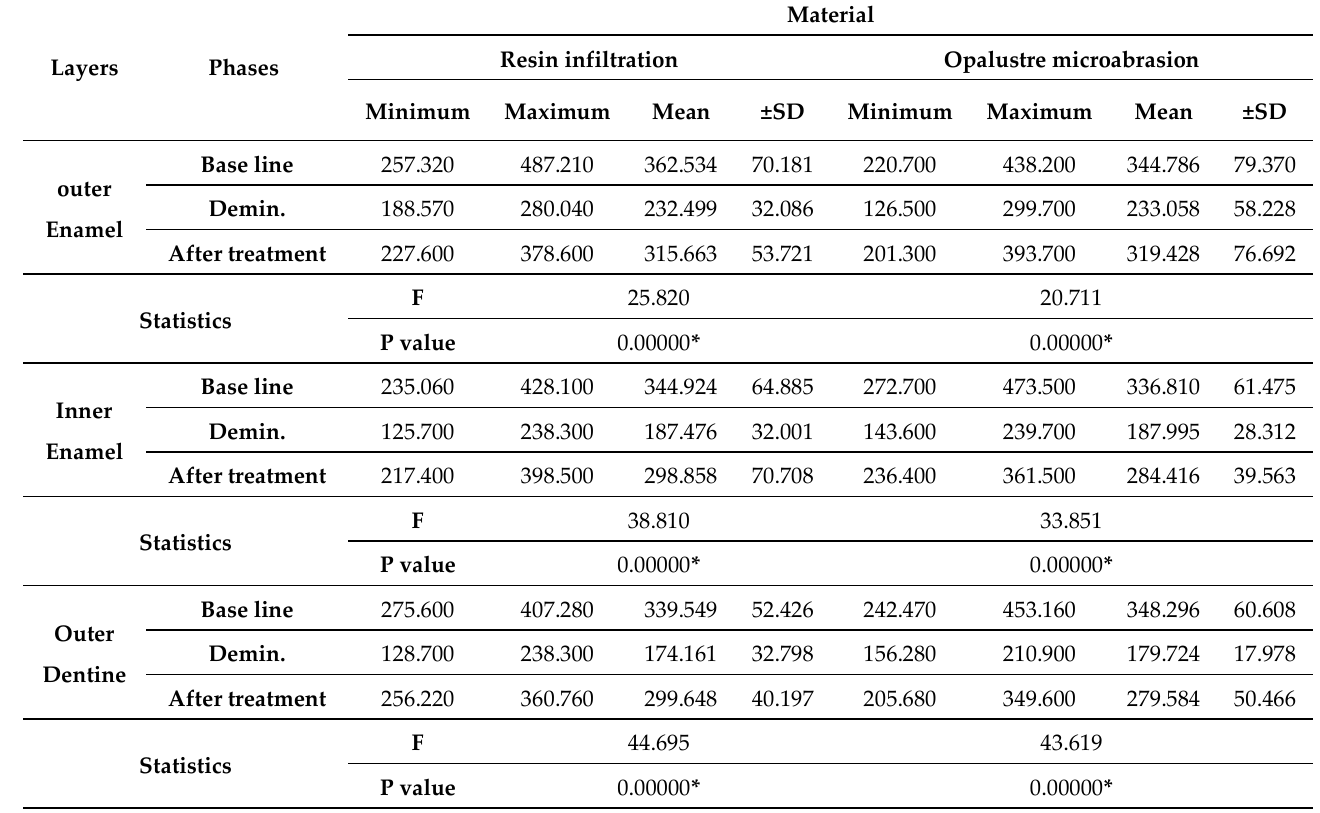
Table 1 : Descriptive and statistical test of Microhardness unit (VHN) among phases and groups by